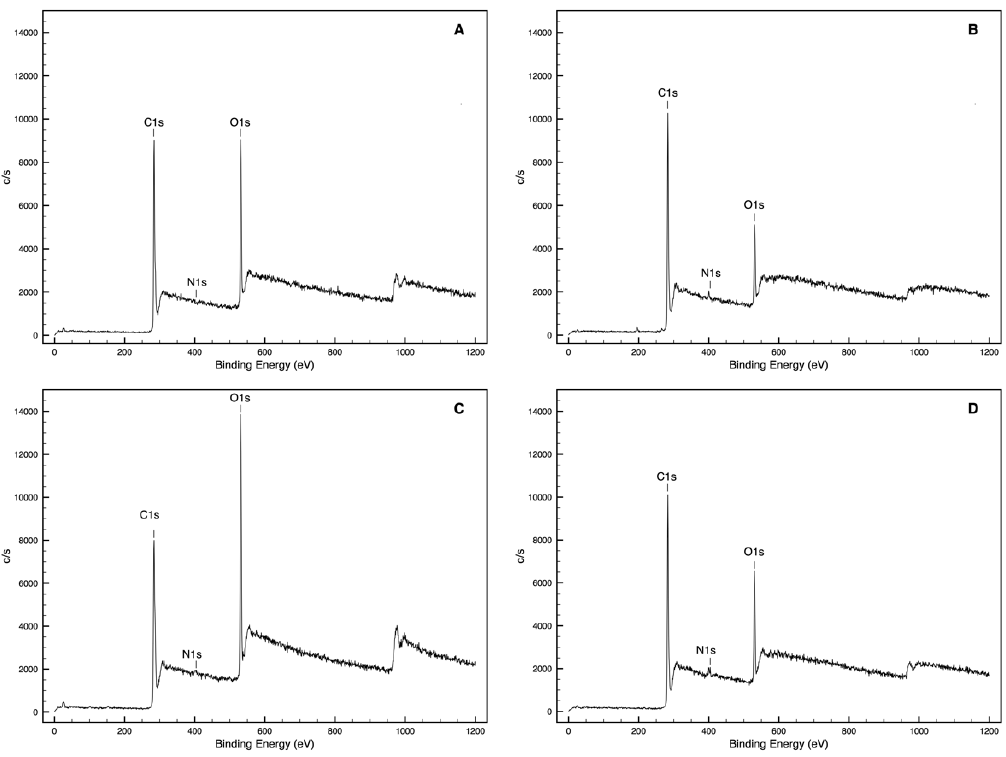
Figure A2. XPS survey scan of polyester nonwoven wipe (W1), ( A ) W1R, ( B ) W1RQ, ( C ) W1P, ( D ) W1PQ.